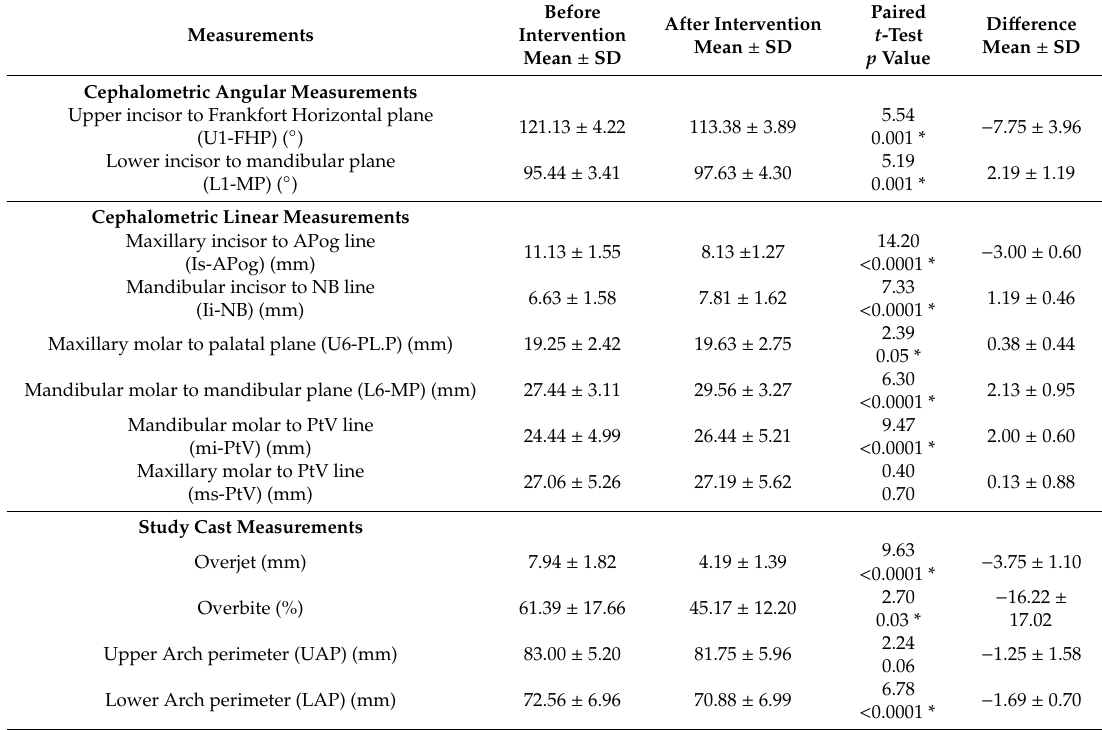
Table 3. Mean dentoalveolar measurements before and after intervention in Group II: twin block.